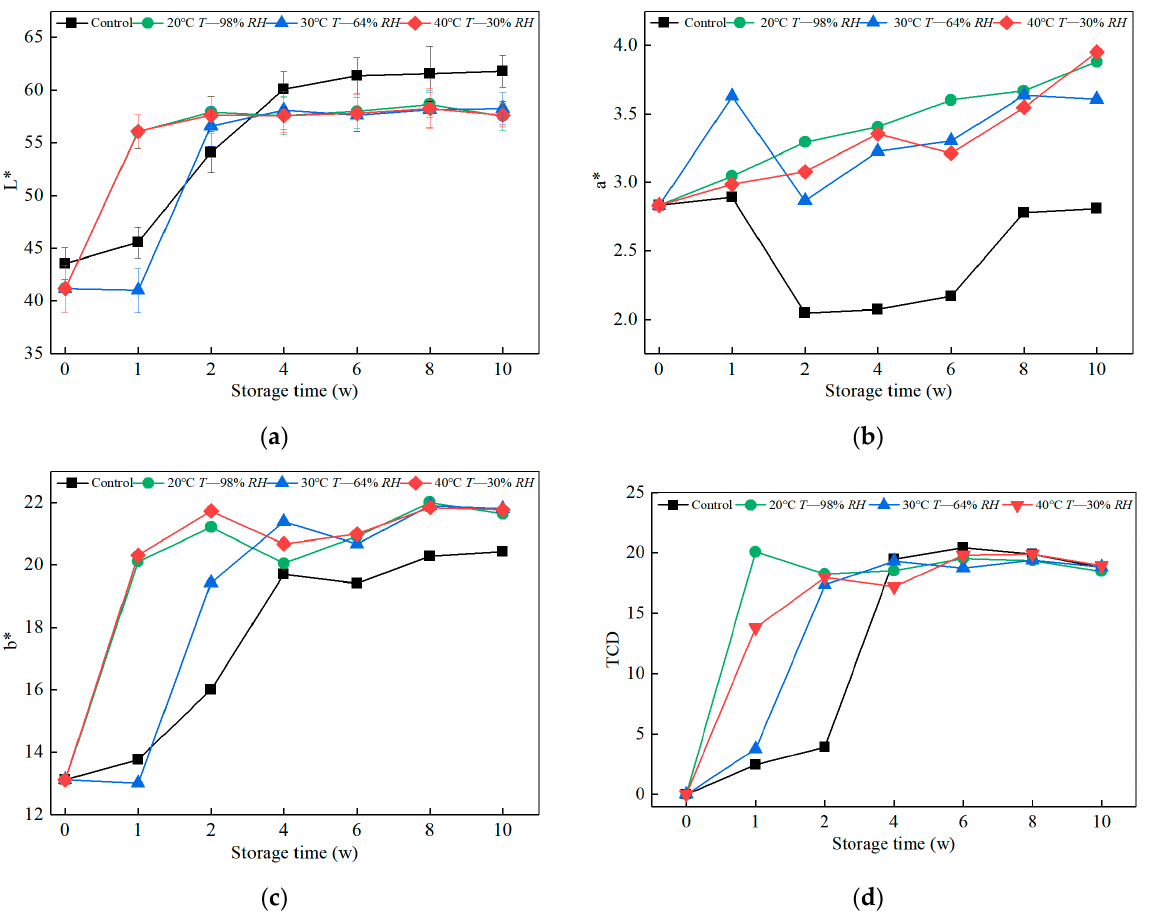
Figure 2. Effect of humidity and heat ageing on the color of the bamboo cortex. ( a ) Lightness values for Bamboo cortex side of all samples. ( b ) Red/green values for Bamboo cortex side of all samples. ( c ) Blue/yellow values for Bamboo cortex side of all samples. ( d ) Total color difference value for Bamboo cortex side of all samples.